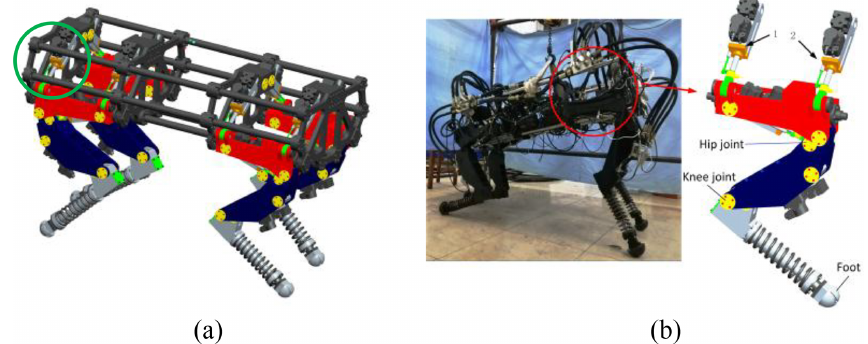
Figure 4. An electrohydraulic servo four-legged robot model. (a) 3D configuration of a four-legged robot with an electrohydraulic system. (b) Single-leg 3D configuration of a four-legged robot.